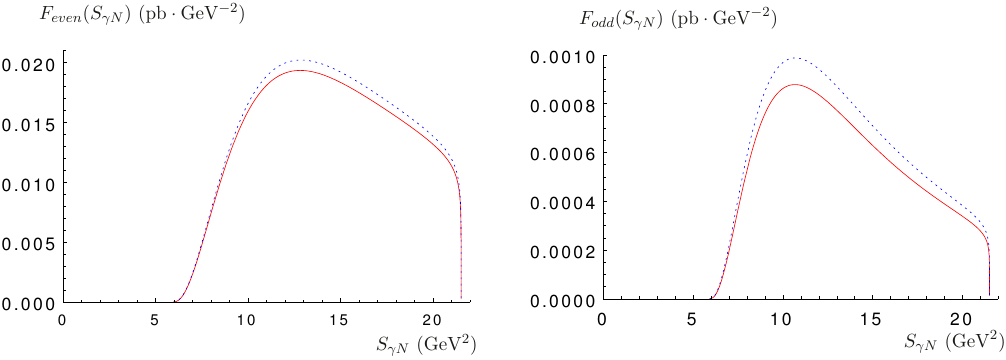
Figure 16 . Shape of the integrand of σ eN , as a function of the invariant mass of the hadronic produced state, on a proton target. Left: longitudinally polarized ρ meson production. Right: transverse ρ meson production. In solid-red: “valence”. In dashed-blue: “standard”.